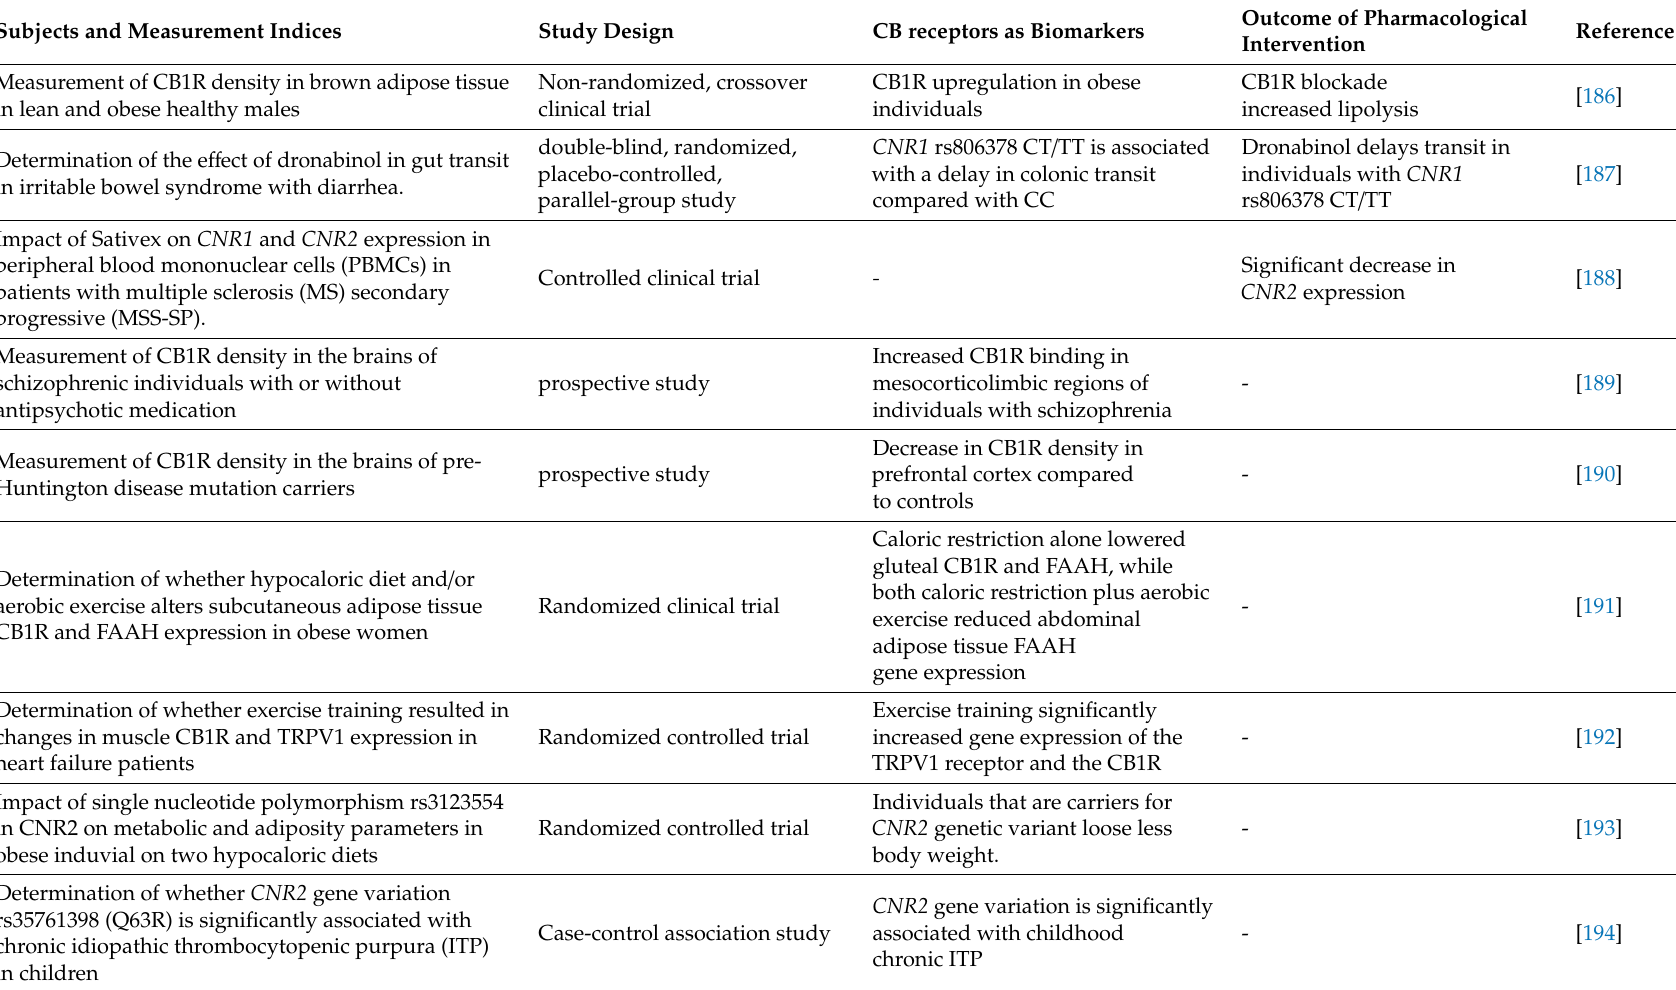
Table 1. Systematic review of recent * clinical studies reporting cannabinoid receptors as biomarkers, and / or investigating the e ffi cacy of cannabinoids in pathological